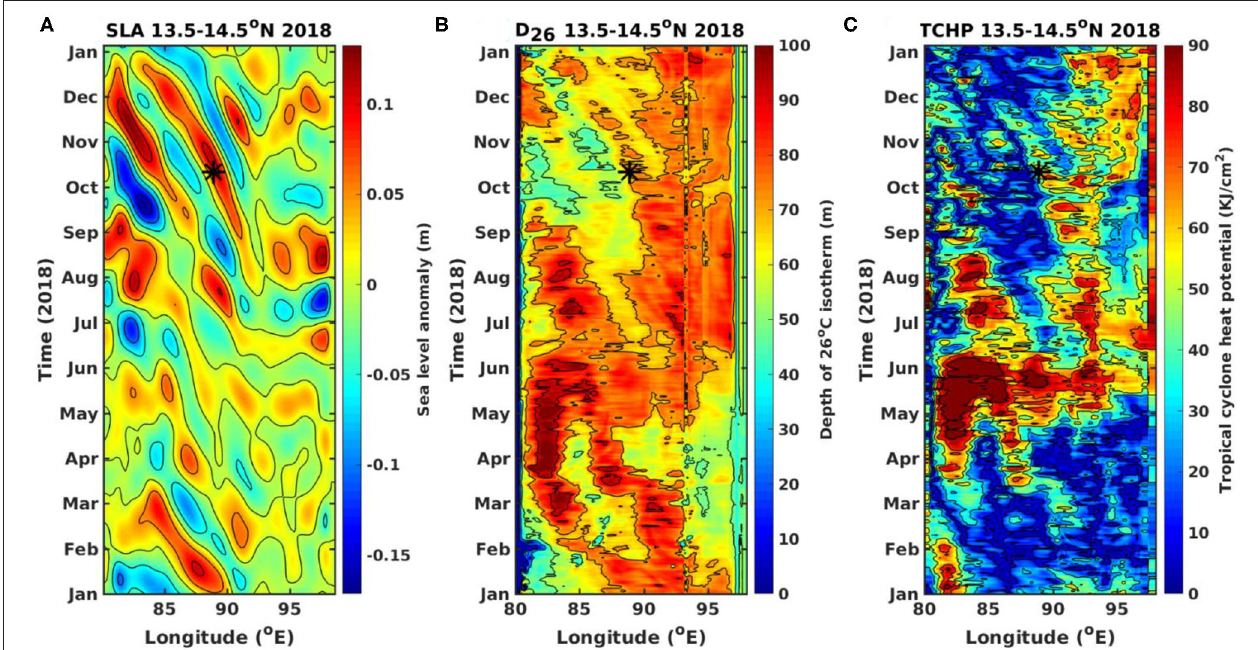
FIGURE 14 | A time-longitude Hovmöller diagram of (A) SLA (m), (B) D 26 (m), and (C) TCHP (kJ/cm 2 ) from January 1 to December 31, 2018, averaged over 13.5–14.5 ◦ N latitude. A black asterisk denotes the location of the origin of the cyclone Titli.